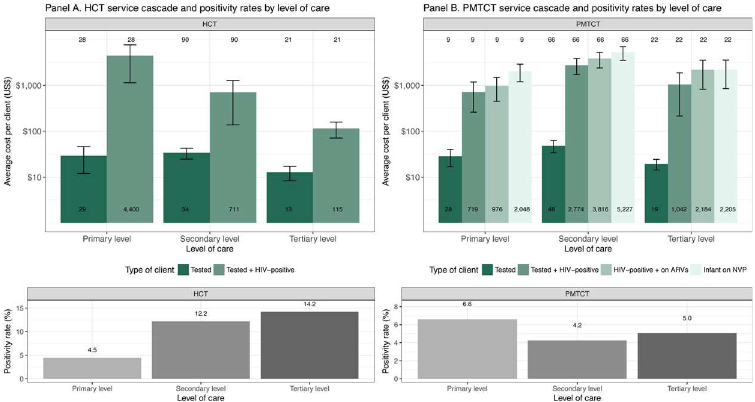
Fig 1. Unit cost per client across the service cascade and positivity rates of HCT and PMTCT services. Note: Labels inside the bars represent actual figures; labels above the bars represent the sample